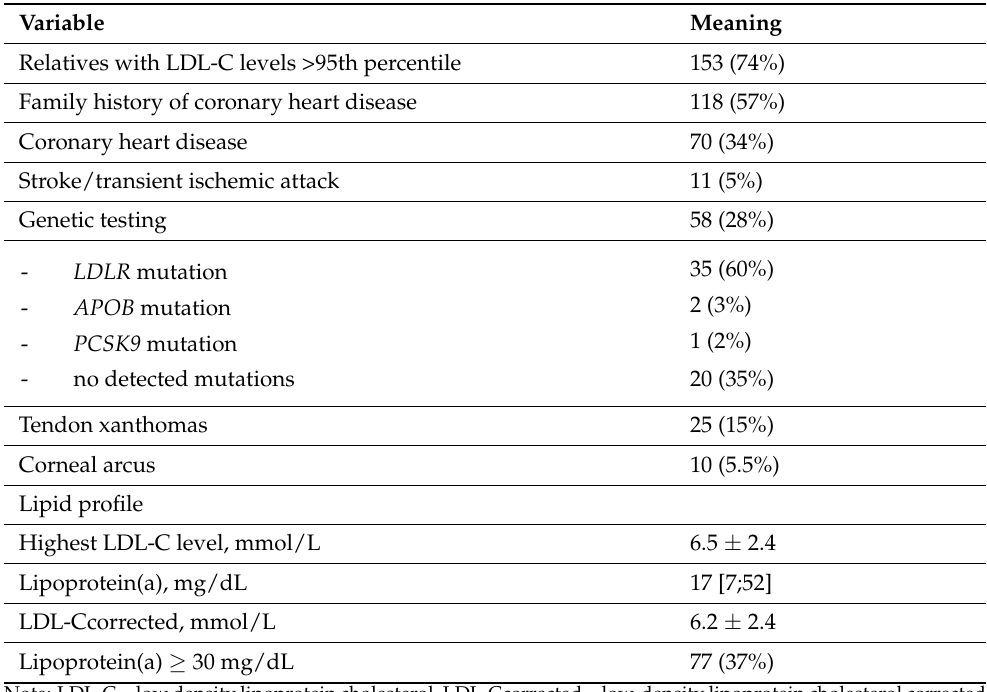
Table 1. Familial hypercholesterolemia diagnosis according to the Dutch Lipid Clinic Network criteria and lipoprotein(a) level ( n =